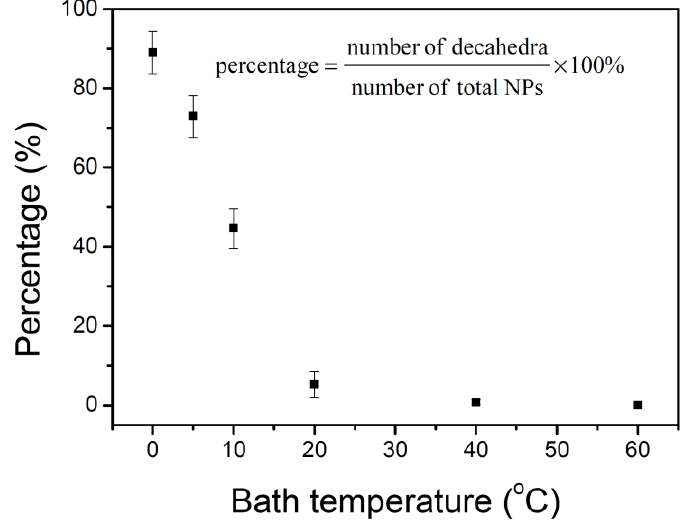
Figure 3. Percentages of decahedral silver nanoparticles in the final products synthesized at various